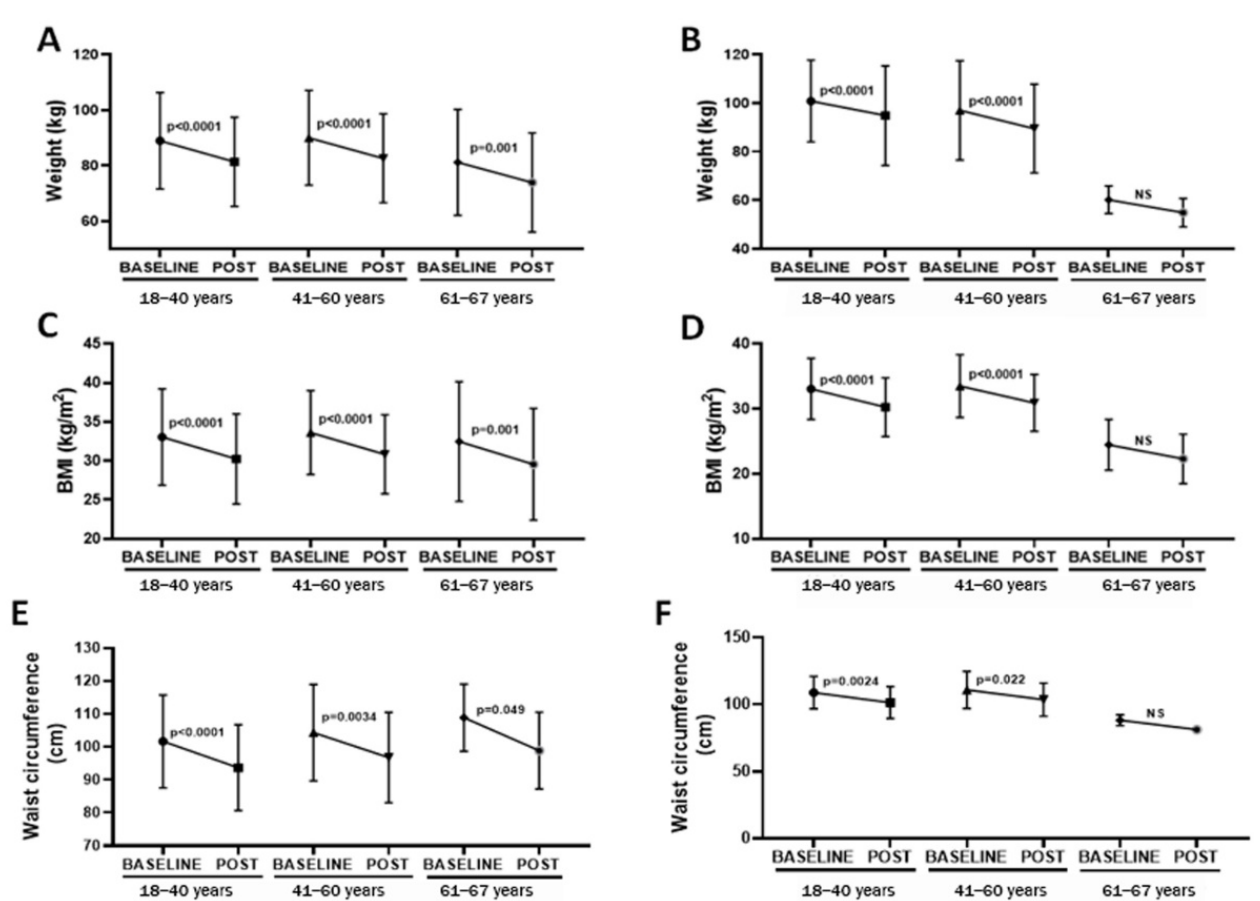
Figure 4. Representation of variation in weight (kg, ( A , B )), BMI (kg/m 2 , ( C , D )), and waist circumference (cm, ( E , F )), presented as the mean and SD, of the volunteers enrolled in the present study separated initially into women ( A , C , E ) and men ( B , D , F ), followed by separation into different ages (from 18 to 40; from 41 to 60; and more than 60 years), both before (BASELINE) and after (POST) 4 Phases Methodology application.